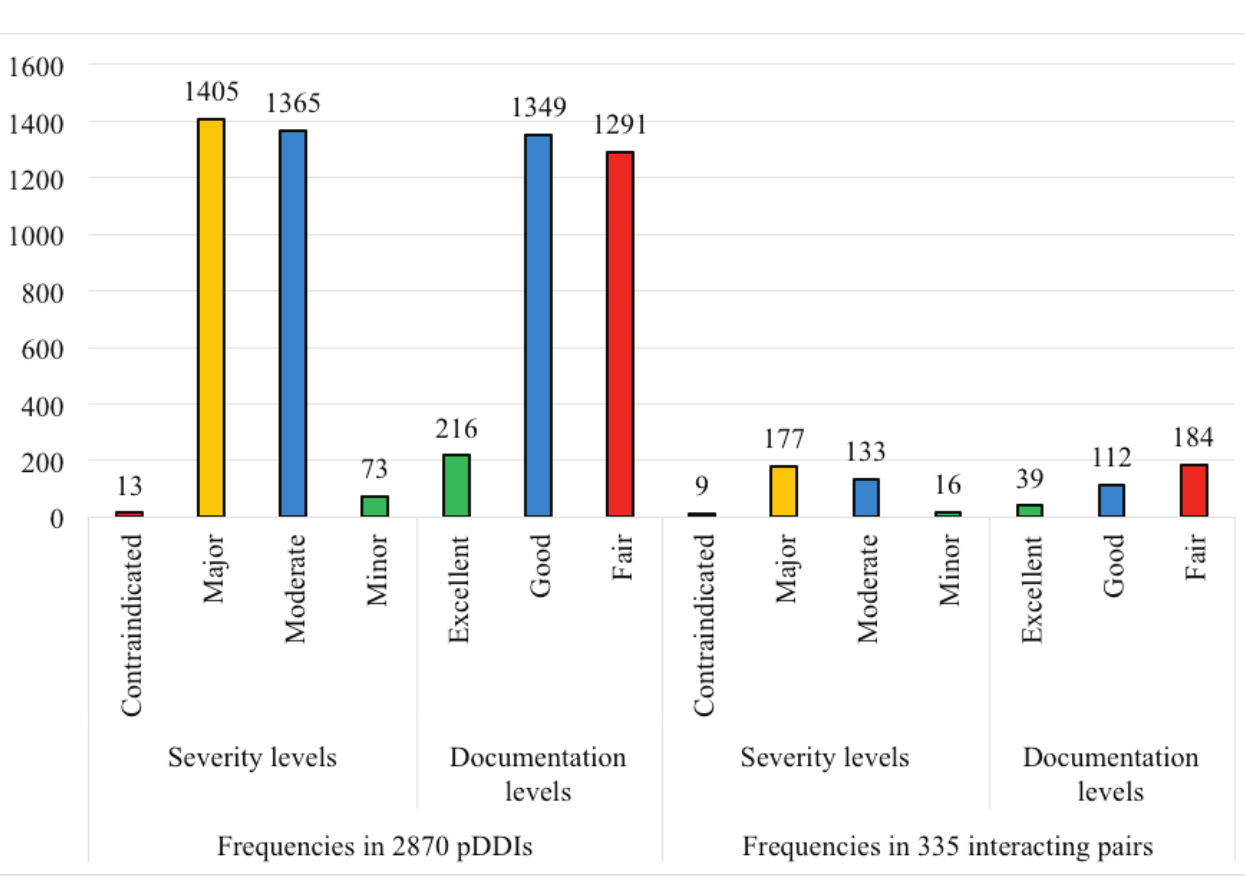
FIGURE 2 - Levels of identified pDDIs. pDDIs = Potential drug-drug